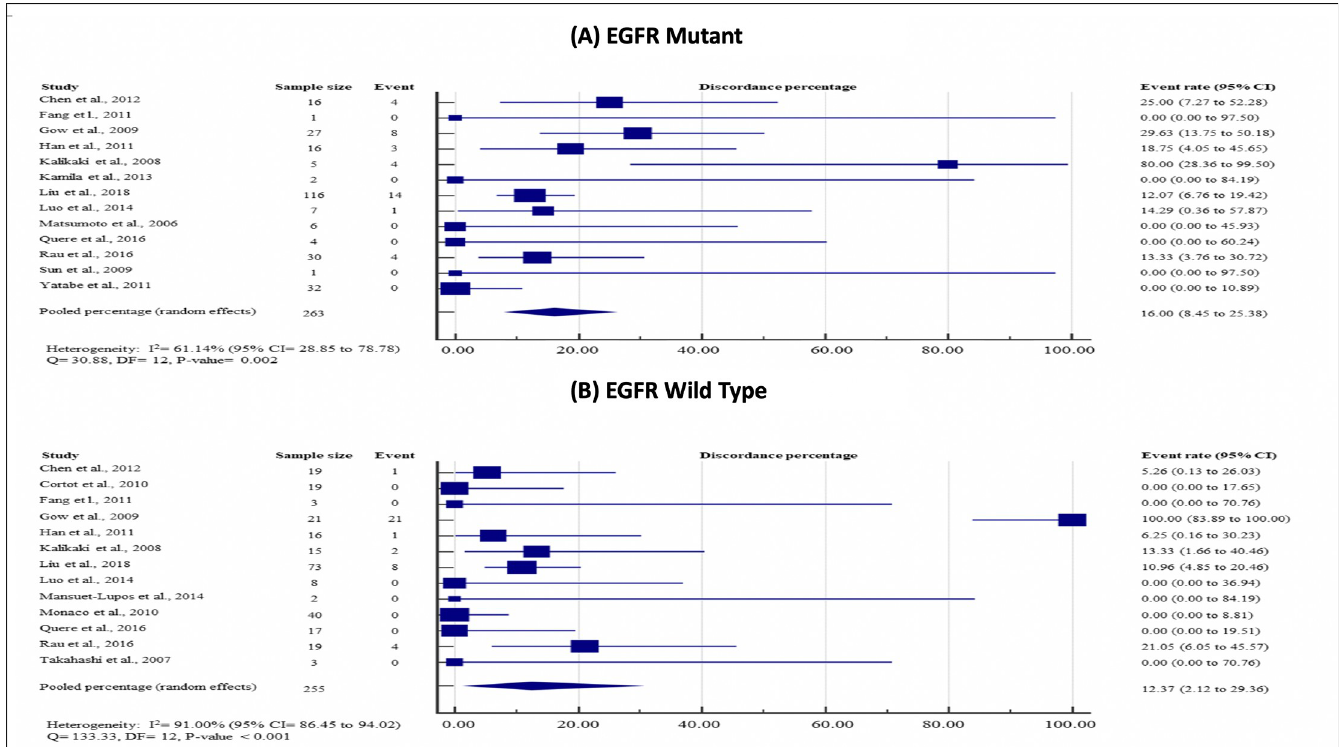
Fig 4. Study-specific and pooled estimates for EGFR mutation discordance percentages by mutation status of primary tumor. (A) EGFR mutant; and (B) EGFR wild-type. Heterogeneity was assessed using I 2 and Q test. Event was defined as discordance of EGFR mutation status between primary lung tumor and paired metastases. Abbreviation: DF = degree of freedom, CI = Confidence interval, EGFR = epidermal growth factor status.